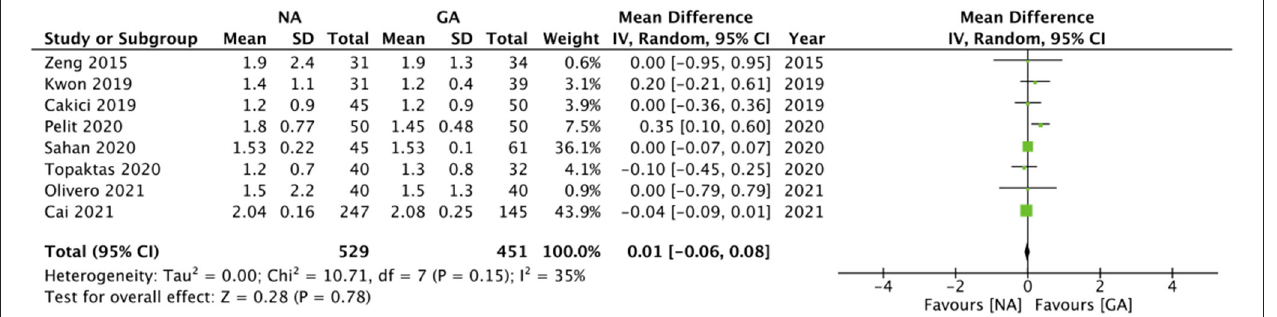
FIGURE 6 | Meta-analysis of LOS between NA and GA for RIRS.